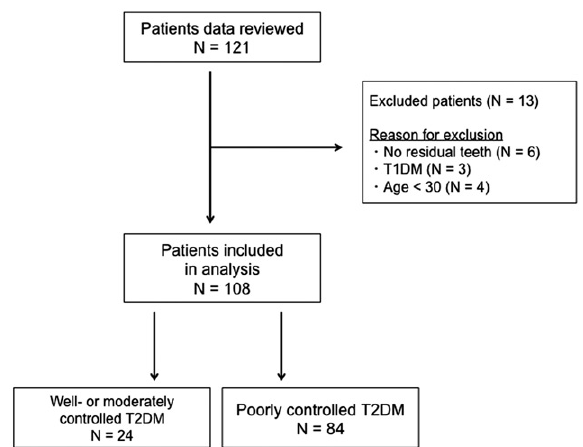
Figure 1. Study flow chart. T1DM: type I diabetes mellitus; T2DM: type 2 dia- betes